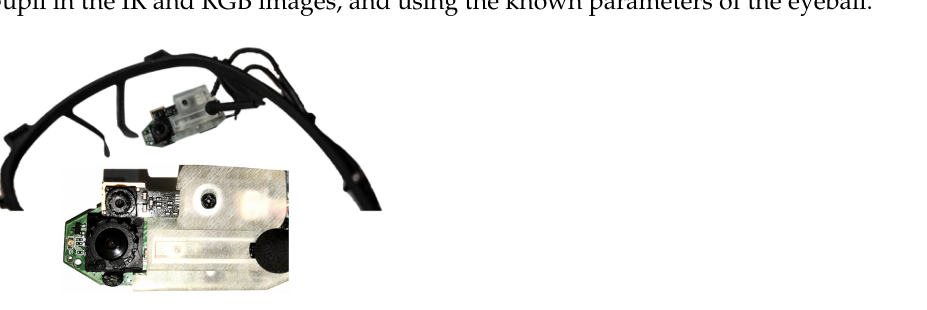
Figure 6. Head-worn corneal imaging glasses and zoomed in view. The upper (small) camera is the IR camera, and the lower is the RGB